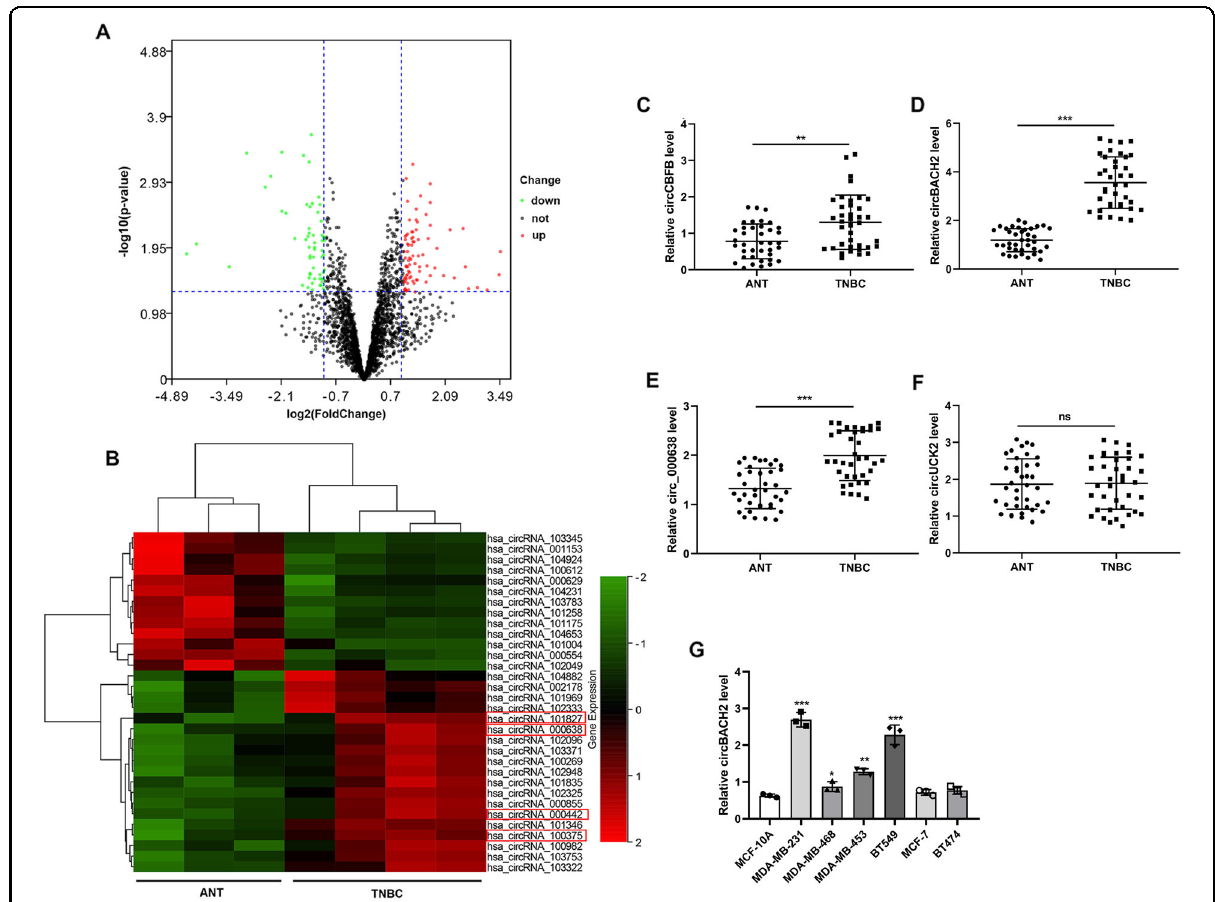
Fig. 1 circBACH2 was upregulated in triple-negative breast cancer (TNBC) tissues and TNBC cell lines. The microarray dataset that is related to TNBC (GSE101123) was downloaded. A The volcano plot visualized the expressions of circRNA between TNBC cancerous tissues ( n = 4) and adjacent normal tissues (ANT; n = 3). The red dots and green dots represent upregulated and downregulated circRNAs with statistical signi fi cance, respectively. B Clustered heat map of the differentially expressed circRNAs in TNBC cancerous tissues ( n = 4) and ANT ( n = 3). Rows represent circRNAs and columns represent tissue types. The color scale runs from green (low intensity) to black (medium intensity), to red (strong intensity). C – F Thirty-eight pairs of TNBC cancerous tissues and ANT were obtained from TNBC patients ( n = 38). The expression levels of circCBFB, circ_000638, circBACH2, and circUCK2 were determined using qRT-PCR. ** P < 0.01, *** P < 0.001. ns no signi fi cance. G The expression level of circBACH2 in the normal mammary gland cell line MCF-10A, TNBC cell lines (MDA-MB-231, MDA-MB-468, MDA-MB-453, and BT-549), estrogen receptor (ER) + /human epidermal receptor 2 (HER2) − cell line MCF-7, and ER + /HER2 + cell line BT-474 was determined using qRT-PCR. * P < 0.05, ** P < 0.01, *** P < 0.001 vs